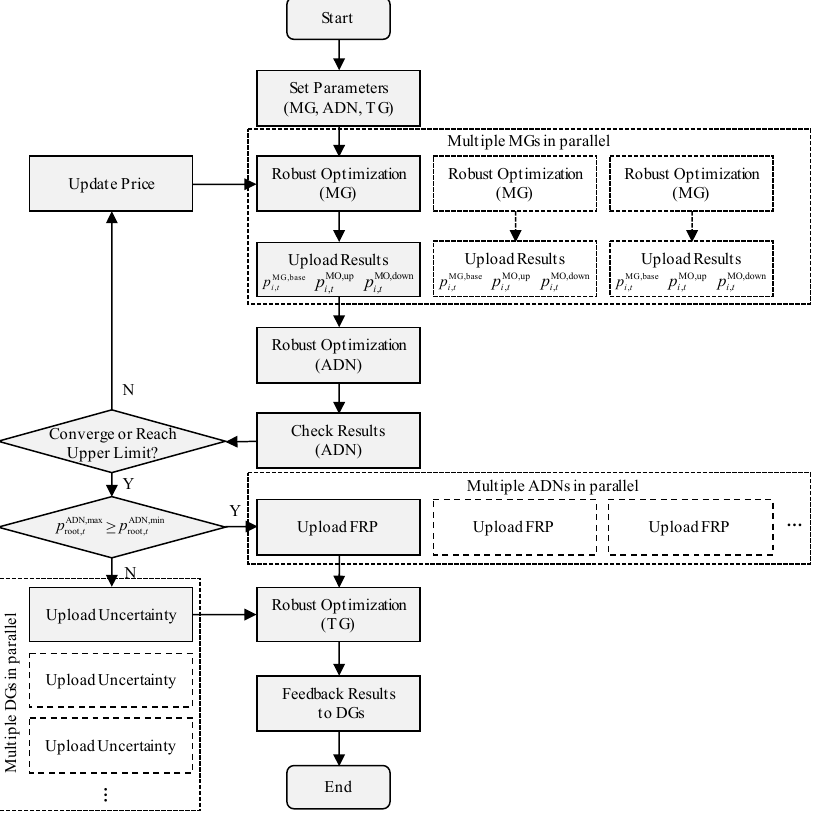
Figure 4. Execution process for multi-level scheduling.